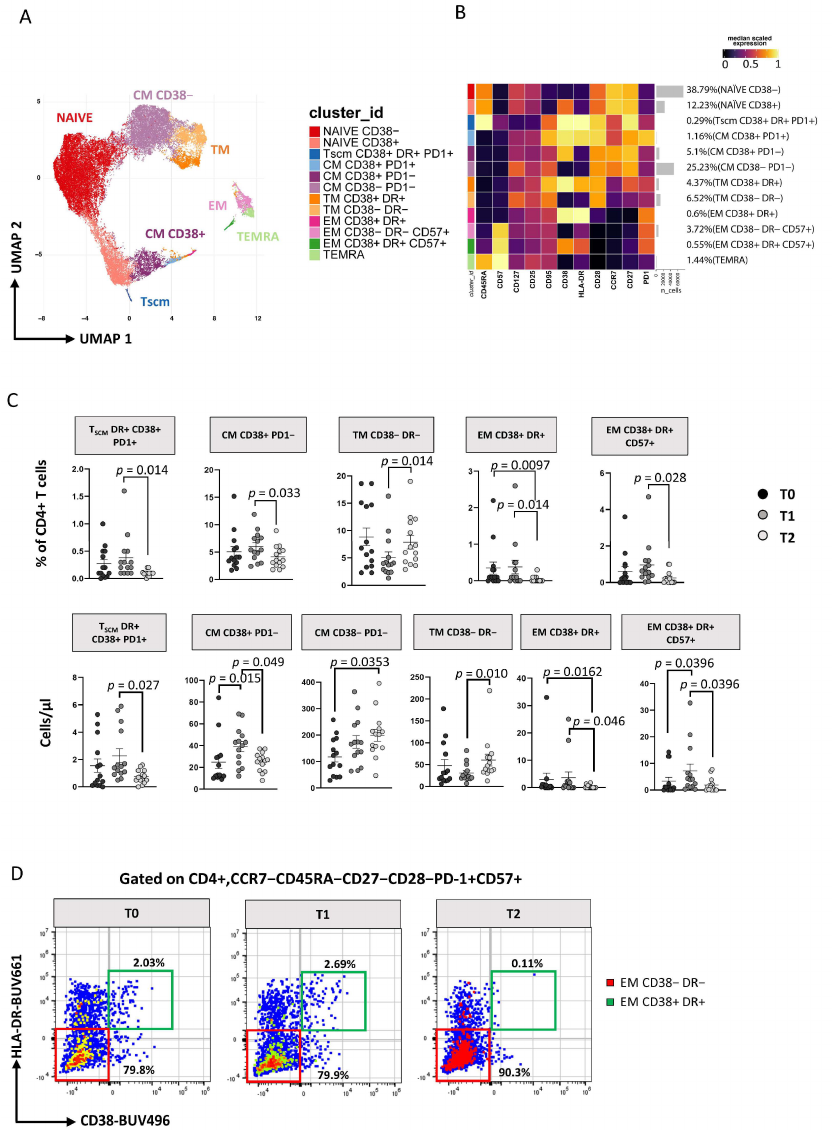
Figure 2. ART induces time-dependent changes in CD4+ T-cell subsets. ( A ) Two-dimension visual- ization of the CD4+ T-cell landscape by UMAP; ( B ) heatmap shows a median-scaled expression of markers across the CD4+ T-cell clusters. Bar plots along the rows and values in brackets on the right indicate the relative sizes of clusters. Twelve clusters were identified by FlowSOM using CD45RA, CD57, CD127, CD25, CD95, CD38, HLA-DR, CD28, CD27 and PD1 markers; ( C ) dot plots show the relative cells percentage (upper) and the absolute number (bottom) of the statistically significant cell clusters at T0 (black circles; n = 14), T1 (grey circles; n = 14) and T2 (light-grey circles; n = 14). The central bar represents the mean ± SEM. The adjusted p -values were obtained by patient pairing generalized linear mixed model (GLMM) that compares cluster percentages or absolute number at T0, T1 and T2, and are reported in the figure (threshold: FDR ≤ 0.05); ( D ) Representative flow cytometry dot plots showing manual gating analysis of EM CD38 − DR − CD57+, and CD38 − DR − CD57+ CD4+ T cells at T0, T1, and T2. Numbers in the dot plots indicate the percentage of cells identified by the